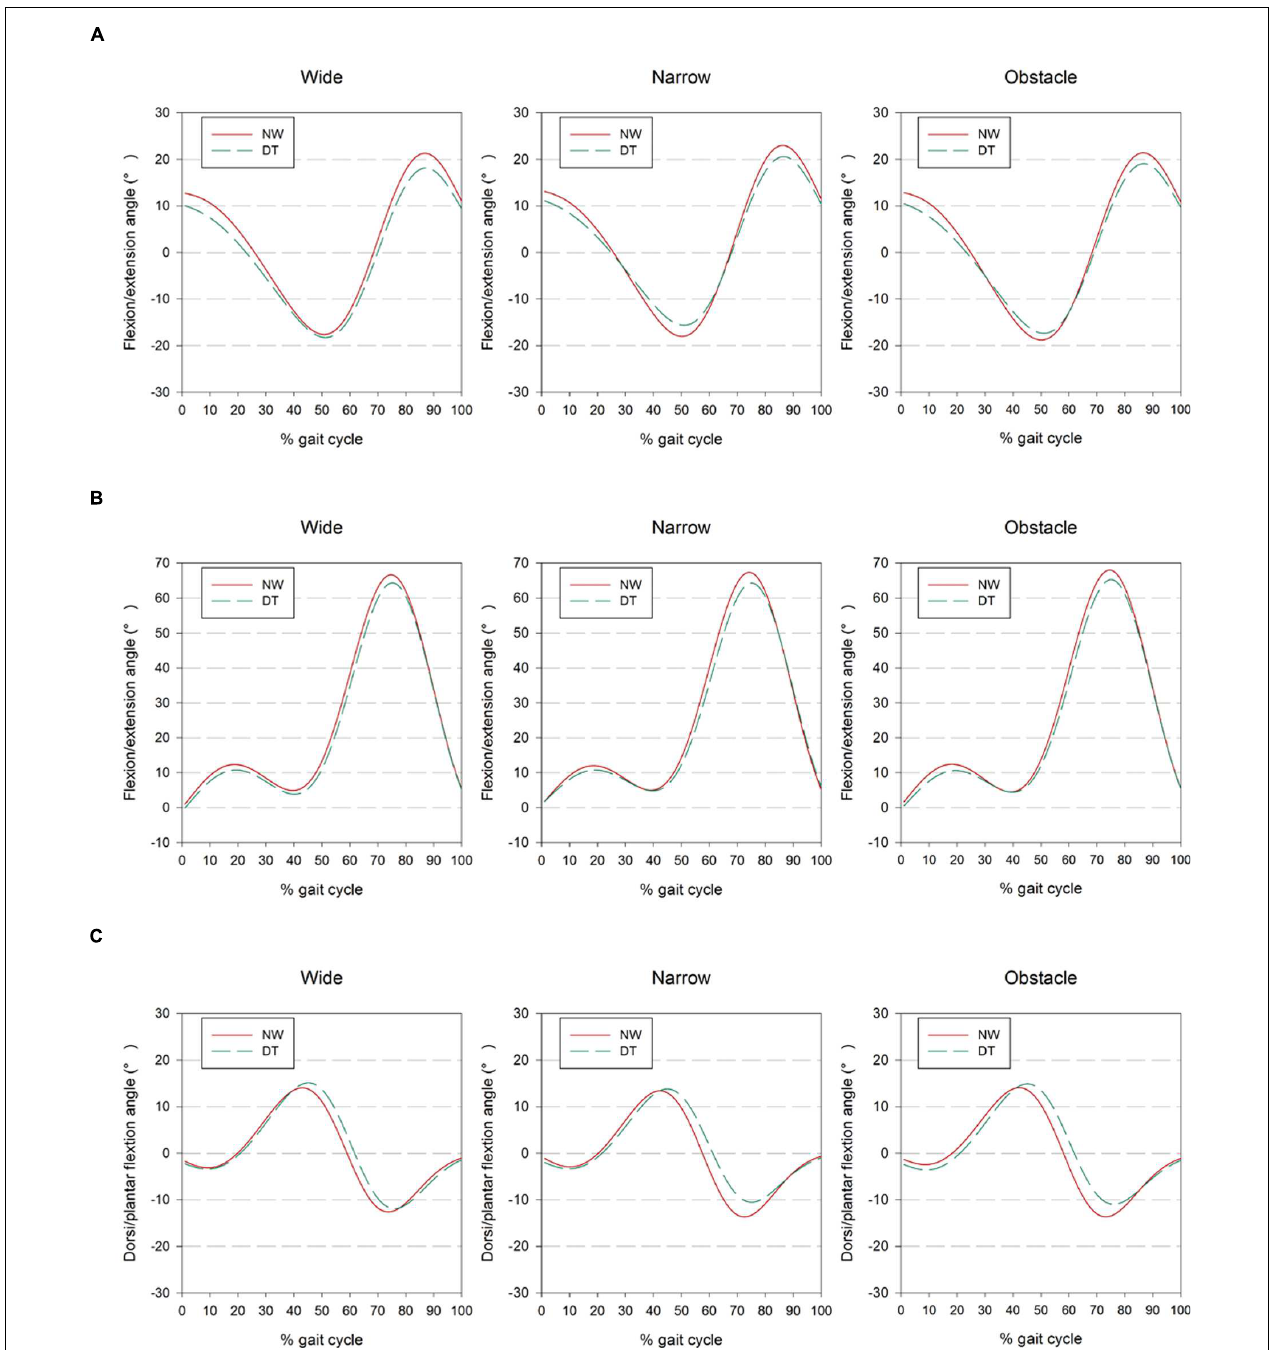
FIGURE 1 | Presentation of (A) hip, (B) knee, and (C) ankle joint kinematics from the right side of 24 participants as ensemble-averaged waveforms for different combinations of cognitive task complexity and walking road condition. The results obtained from 1-back and 3-back task are combined and showed as DT for